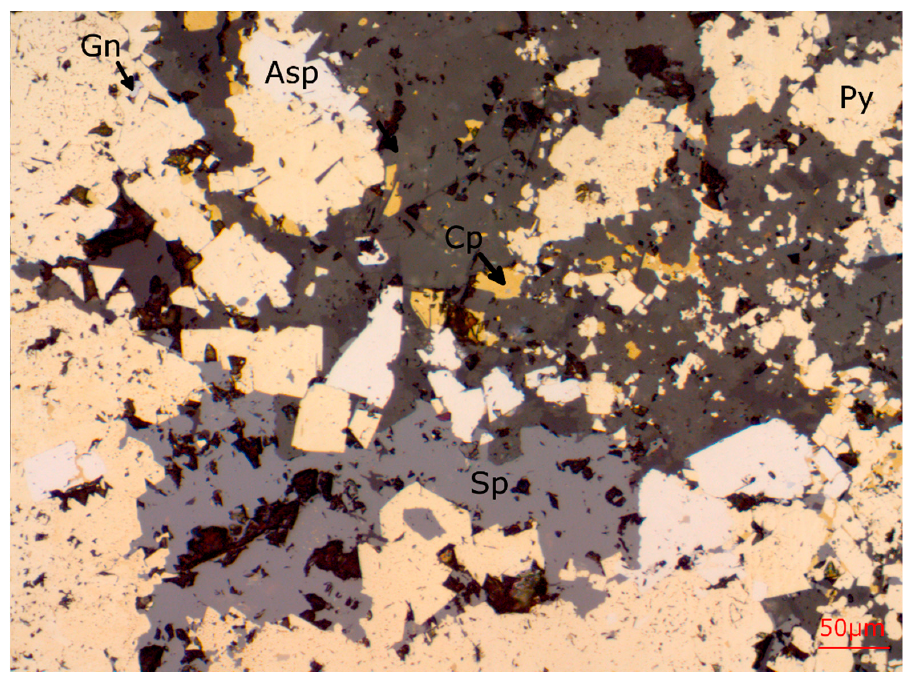
Figure 7. Reflected light photomicrograph from the L4-14-132.0 polished thin section. Chalcopyrite grains occur as disseminated grains within Py, Asp, and gangue, but are mostly concentrated in gangue-rich areas. Coarse-grained, inclusion free (relatively) Sp occurs mainly along pyrite-gangue zones.